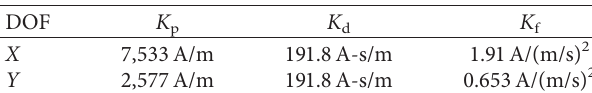
Figure 2: Block diagram of the shaking table position control. Table 2: Controller gain